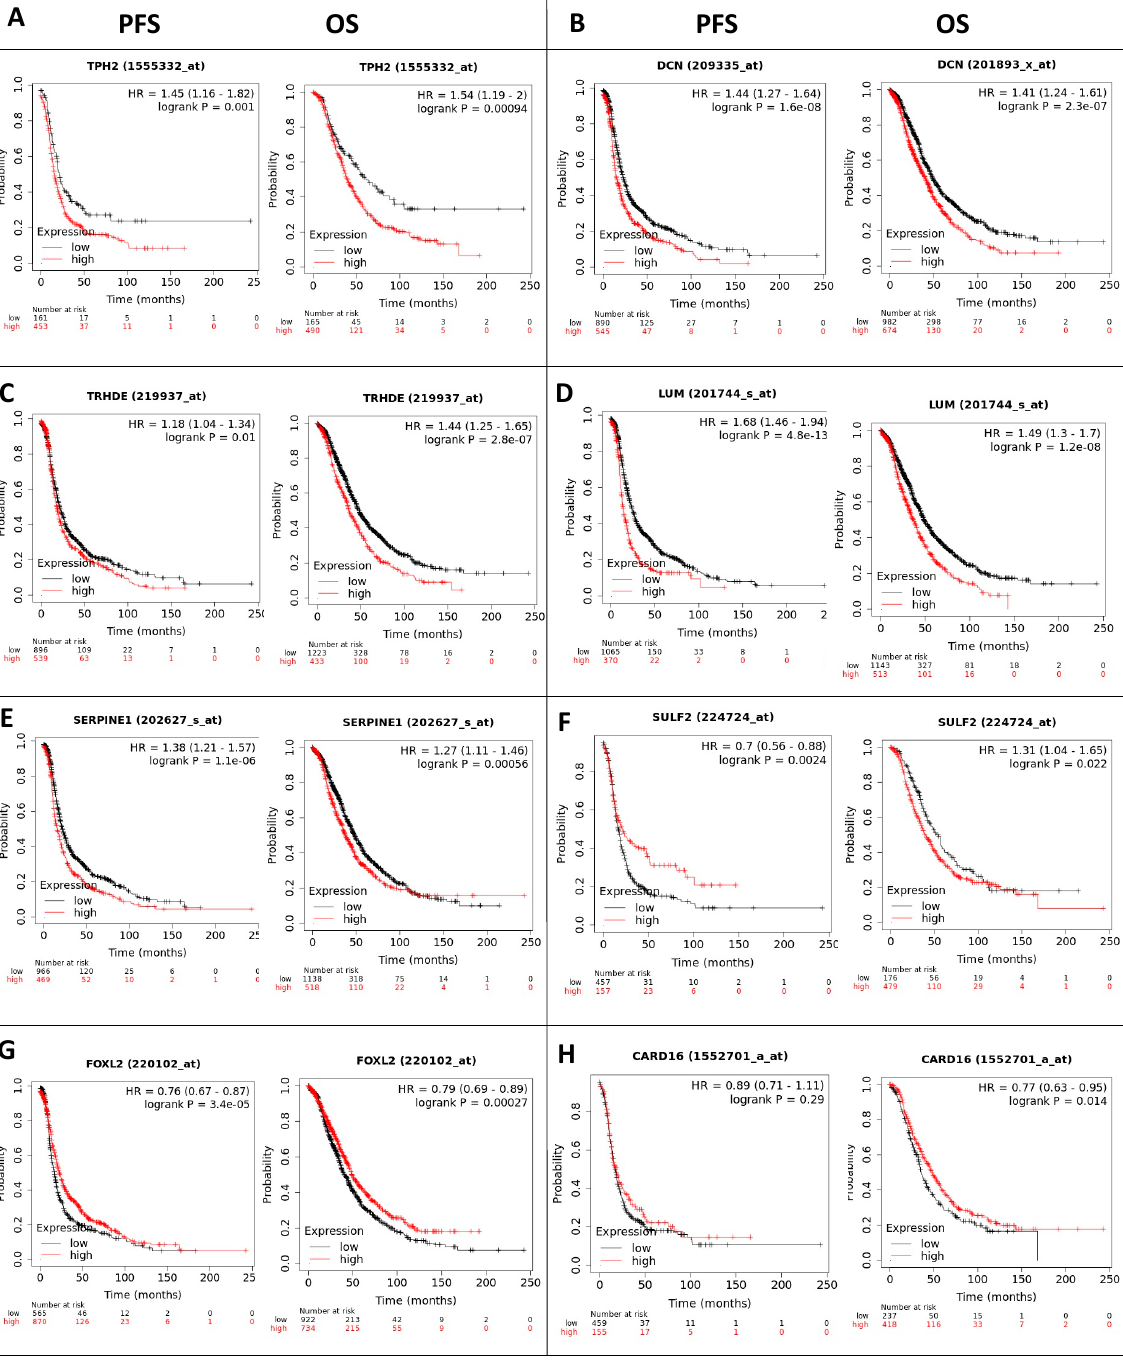
Figure 7. KM plots: Survival plots of ovarian cancer patients were generated using the KM plotter database for the top 10 differentially abundant RNA transcripts of the RNAseq experiments-TPH2 ( A ), DCN ( B ), TRHD2 ( C ), LUM ( D ), SERPINE1 ( E ), SULF2 ( F ), FOXL2 ( G ) and CARD16 ( H ). The OS and PFS of the ovarian cancer patients were stratified based on the median RNA expression levels for each gene. * p < 0.05 was considered significant.